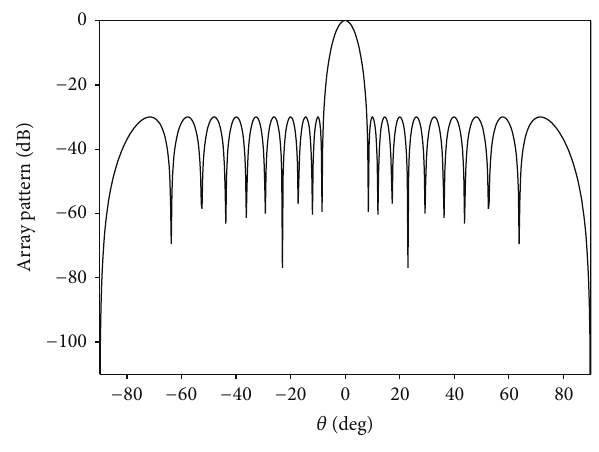
Figure 2: Initial Chebyshev